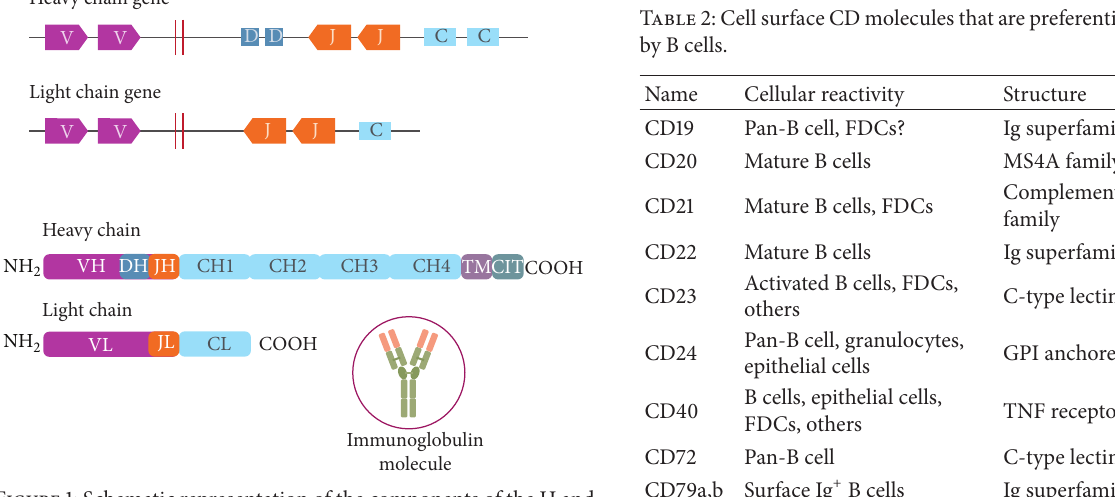
Figure 1: Schematic representation of the components of the H and L chains of immunoglobulins. The light and heavy chain loci are each made up of a series of V (variable) gene elements, followed by several D (diversity) segments (for the heavy chain gene only), some J (joining) segments, and C (constant region) exons. Heavy chains (H) are assembled from 4 segments (VH, D, JH, and CH); light chains (L) are assembled from 3 segments (VL, JL, and CL). The development of the BCR begins when the recombinase enzyme complex catalyzes the fusion of one DH region gene to a JH region gene with the deletion of the intermediate DNA sequences. Next, the recombinase joins one VH region gene to the rearranged DHJH gene. The enzyme terminal deoxynucleotidyl transferase (TdT) is expressed, adding random nucleotides to the sites of VHDHJH joining and enhancing the diversity of amino acid sequences. The rearranged VHDHJH element forms the most 5 󸀠 exon of the H chain gene and is followed downstream by exons encoding the constant (C) region (initially 𝜇 chain), that pairs with an L chain and producesIgM.WhentheVHDHJHelementisfolloweddownstream by exons encoding the C region for the 𝛿 chain, it produces IgD. These events occur as a result of alternative RNA splicing. Finally, if the rearrangement of VH, DH, and JH elements yields an H chain transcript and encodes a functional H chain protein, this heavy chain is synthesized and pairs in with 2 proteins (called 𝜆 5 and VpreB), which act as a surrogate light chain, and results in the expression of a pre-BCR. Once a functional heavy chain is produced, the cell downregulates the TdT gene and initiates an L chain rearrangement. It begins first with a 𝜅 element and, if this rearrangement is unsuccessful, continues with a 𝜆 element.